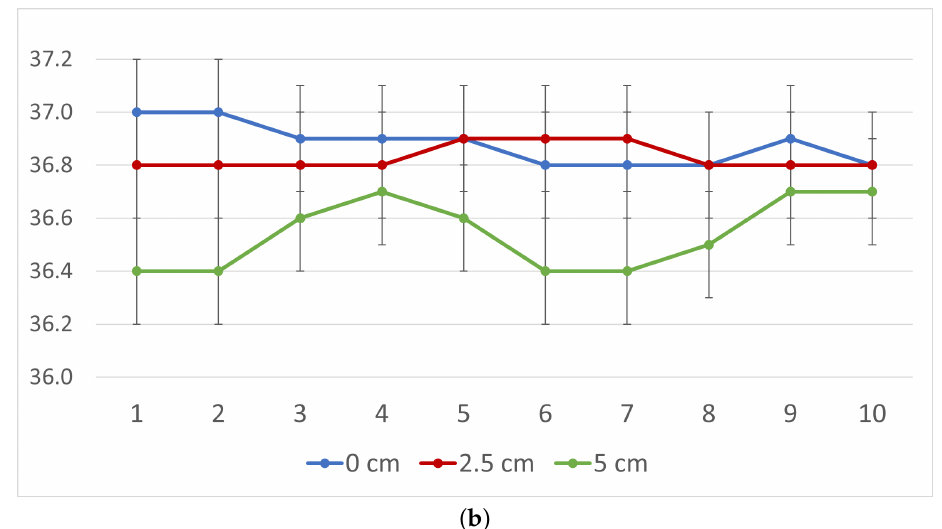
Figure 6. Trend of 10 body temperature measurements with the same device, at different distances from the patient’s forehead: ( a ) excess of the measured value in a subject with a temperature of 36.5 ◦ C; ( b ) variability in the measured value according to the distance from the patient’s